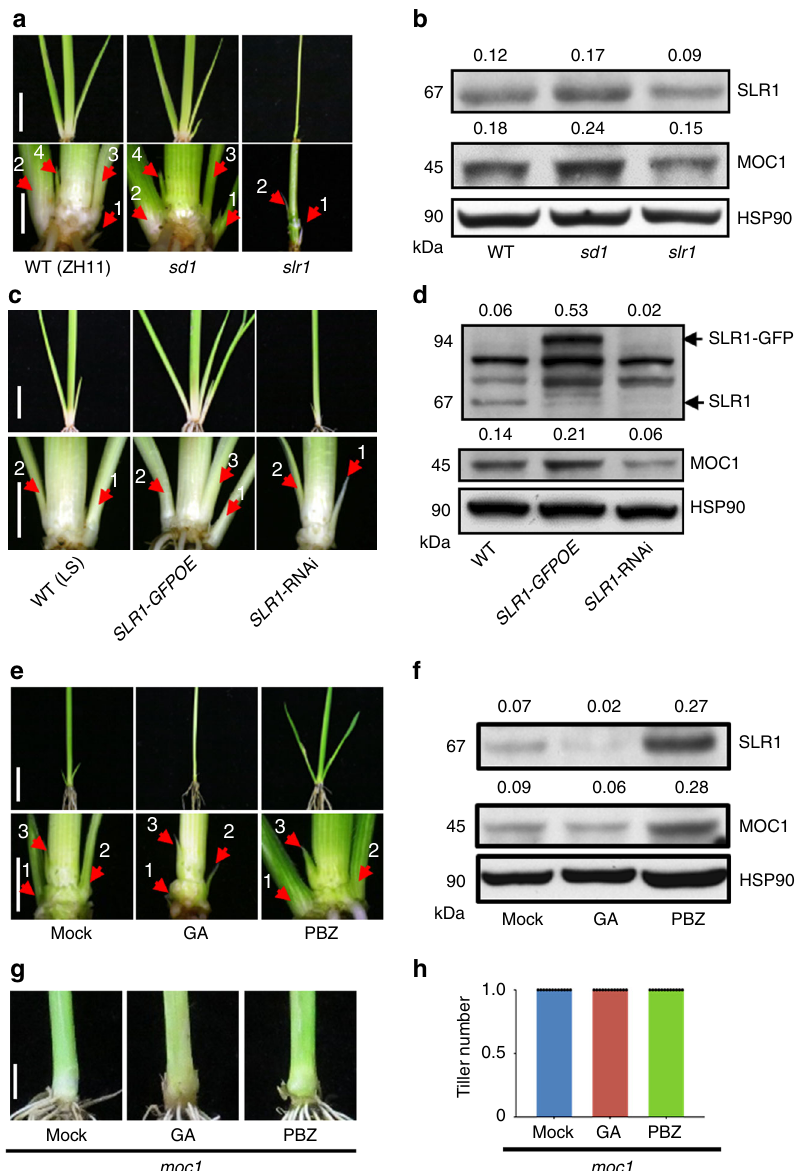
Fig. 2 GA signaling inhibits tiller bud outgrowth and the protein level of MOC1. a Shoot bases of the WT (ZH11), sd1 , and slr1 seedlings at 30 DAG. The bottom row shows magni fi ed images. The arrows indicate axillary buds or tillers. Scale bar, 2 cm (top) and 0.5 cm (bottom). b Protein levels of SLR1 and MOC1 in WT, sd1 , and slr1 , determined by protein blotting. Heat-shock protein 90 (HSP90), loading control. Values above panels indicate signal strength for SLR1 and MOC1 in arbitrary units determined by densitometry. c Shoot bases of WT (LS), SLR1-GFPOE, and SLR1- RNAi seedlings at 30 DAG. The bottom row shows the magni fi ed images. Arrows indicate axillary buds or tillers. Scale bar, 2 cm (top) and 0.5 cm (bottom). d Protein blotting shows protein levels of SLR1 and MOC1 in WT (LS), SLR1-GFPOE , and SLR1 -RNAi transgenic plants. HSP90, loading control. Values above panels indicate as in ( b ). e Effects of GA and PBZ treatments on tiller bud outgrowth. The bottom row shows the magni fi ed images. Arrows indicate axillary buds or tillers. Scale bar, 2 cm (top) and 0.5 cm (bottom). f Effects of GA and PBZ treatments on SLR1 and MOC1 protein levels, determined by protein blotting. HSP90, loading control. Values above panels indicate as in ( b ). g Effects of GA and PBZ treatments on the tiller number of moc1 . Scale bar, 0.5 cm. h Quanti fi cation of the tiller number shown in ( g ) ( n = 12). The full scans of immunoblots are shown in Supplementary Fig. 12. Source data are provided as a Source Data fi